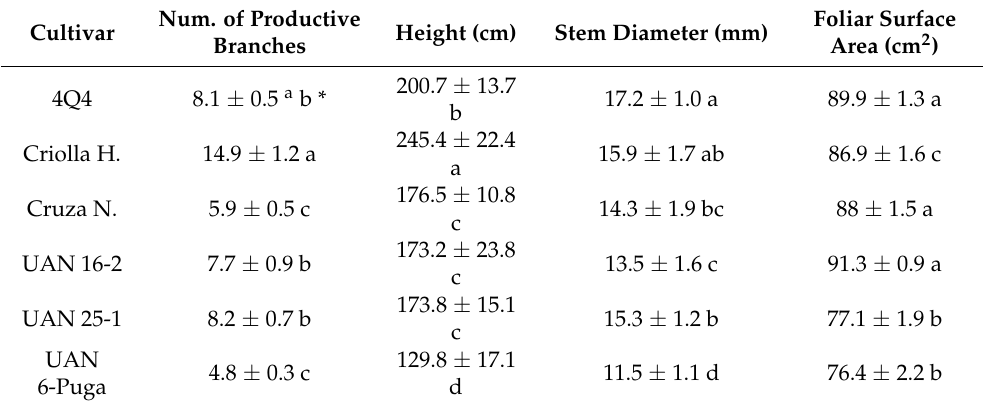
Table 2. Number of productive branches, height, stem diameter and foliar surface area of different roselle cultivars produced in greenhouse hydroponics.